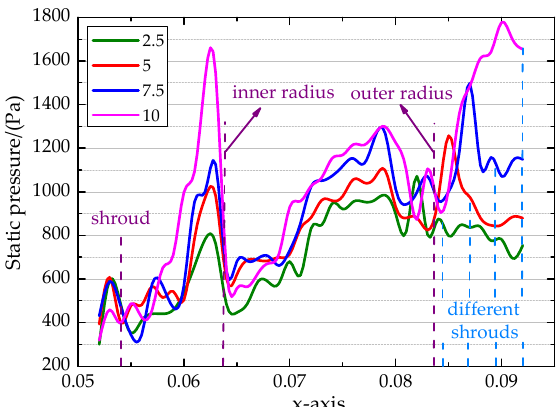
Figure 15. Change rules of static pressure along the x -axis under the different values of the distance c 2 .